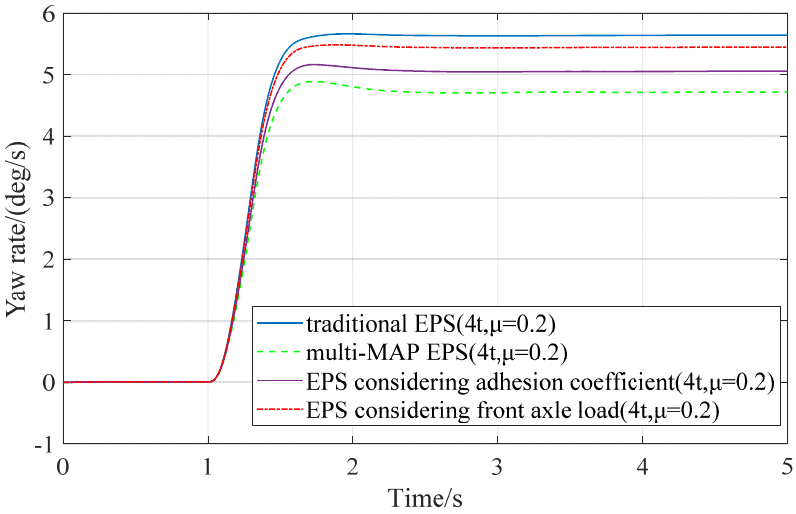
Figure 11. Comparison of yaw rate of different EPS.